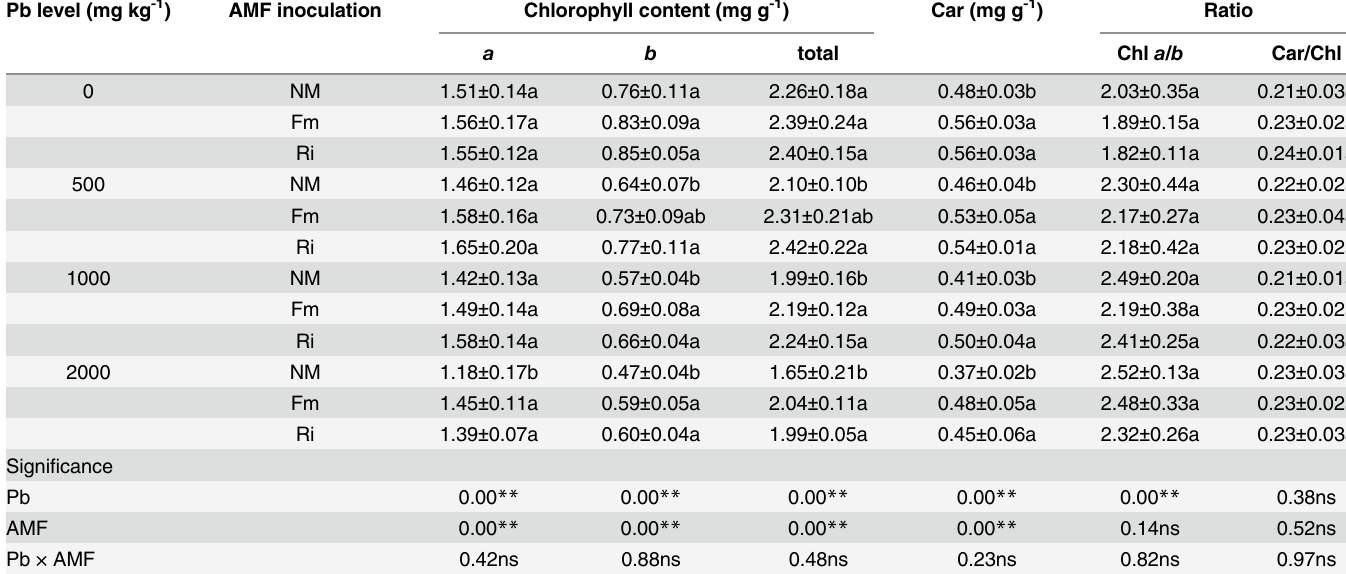
Table 2. Leaf contents of total chlorophyll (Chl), Chl a , Chl b , carotenoid (Car), and the Chl a / b and Car/Chl ratios of R . pseudoacacia were affected by Pb stress levels and AMF inoculation. Pb level (mg kg -1 )